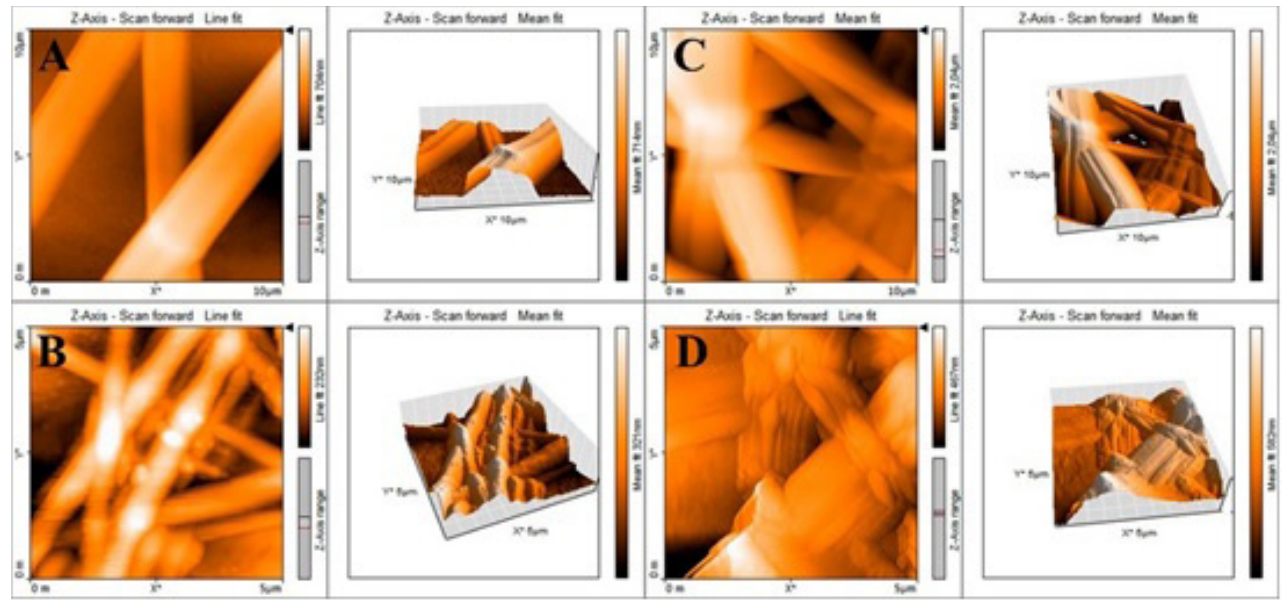
FIGURE 5 - 2D and 3D AFM images of a) PVA/SA b) GTA/PVA/SA c) NFT/PVA/SA and d) GTA/NFT/PVA/SA